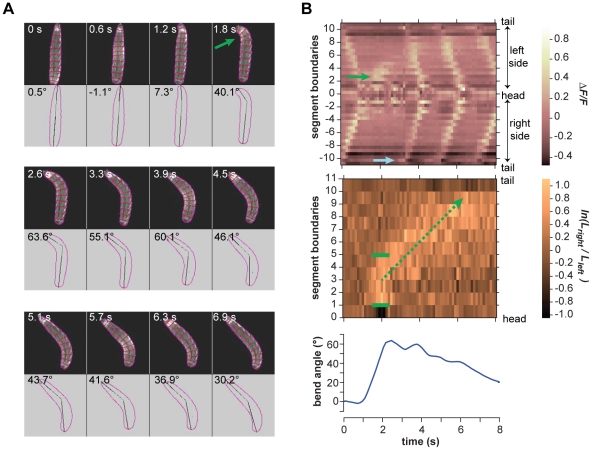
Turning decisions with small head sweeps.
A. Video frames of an example small head sweep during cooling. Upper panel in each video frame shows fluorescence image. Outline and boundaries between segments are shown in red. Lower panel in each video frame shows the perimeter, centerline, and body bend angle as analyzed by machine vision software. Green arrow shows the asymmetric bend that is flagged as a head sweep. B.
(Upper panel) Kymograph of fluorescence intensity within body segments for the video segment shown in A. Green arrow shows the increase in fluorescence intensity on the left side of the animal, signifying the leftward head sweep. Blue arrow shows the increase in fluorescence intensity in the A8 segment, signifying the resumption of peristalsis at the tail. (Middle panel) Kymograph of the logarithm of the ratio between the lengths of segment boundaries on the left side and right side of the animal. Green brackets indicate the margins of the region of asymmetric contraction, positive values signifying the leftward bend. Green arrow shows the retrograde progression of the region of asymmetric contraction during the four subsequent peristalsis waves. (Lower panel) Time course of body bend angle, operationally defined to flag reorientation maneuvers as described in Materials and Methods, shows the initial rise that signifies the leftward head sweep and gradual decline as subsequent peristalsis waves straighten the body.